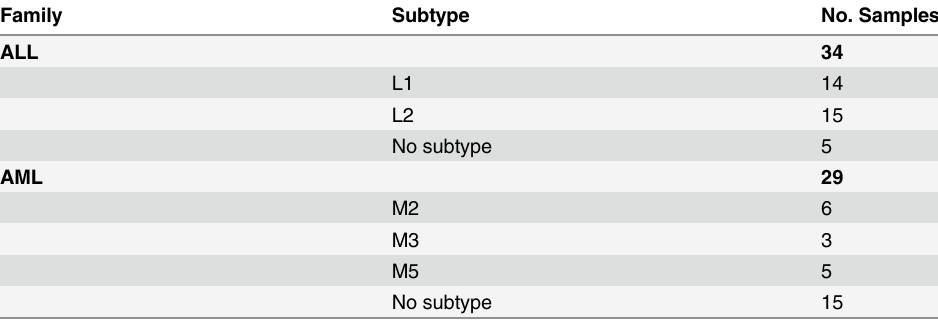
Table 3. Patients by